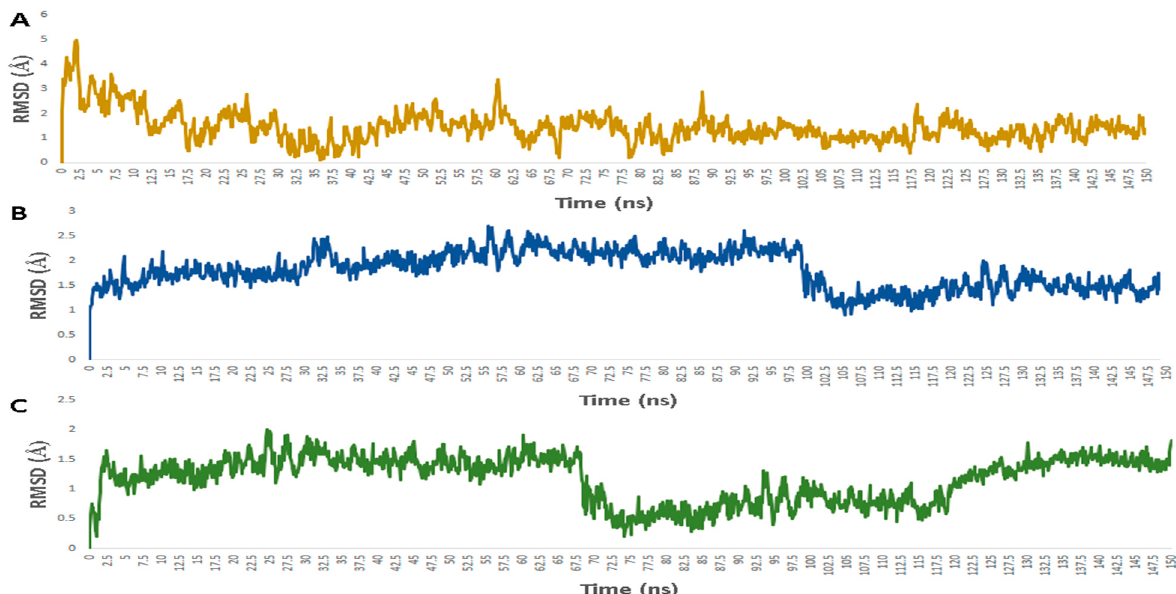
Figure 10. RMSDs of cnicin inside the binding sites of the human proteins: ( A ) NPR, ( B ) GAK, and ( C ) AAK1.